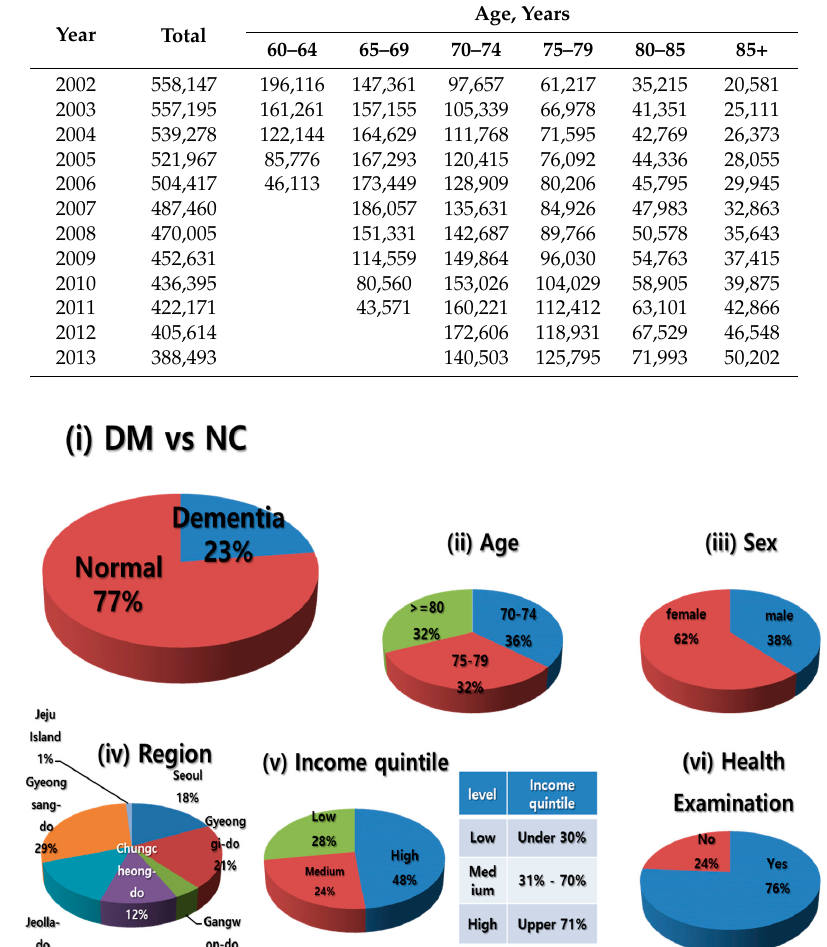
Table 2. KNHIS-SC DB population. Table 2. KNHIS ‐ SC DB population.